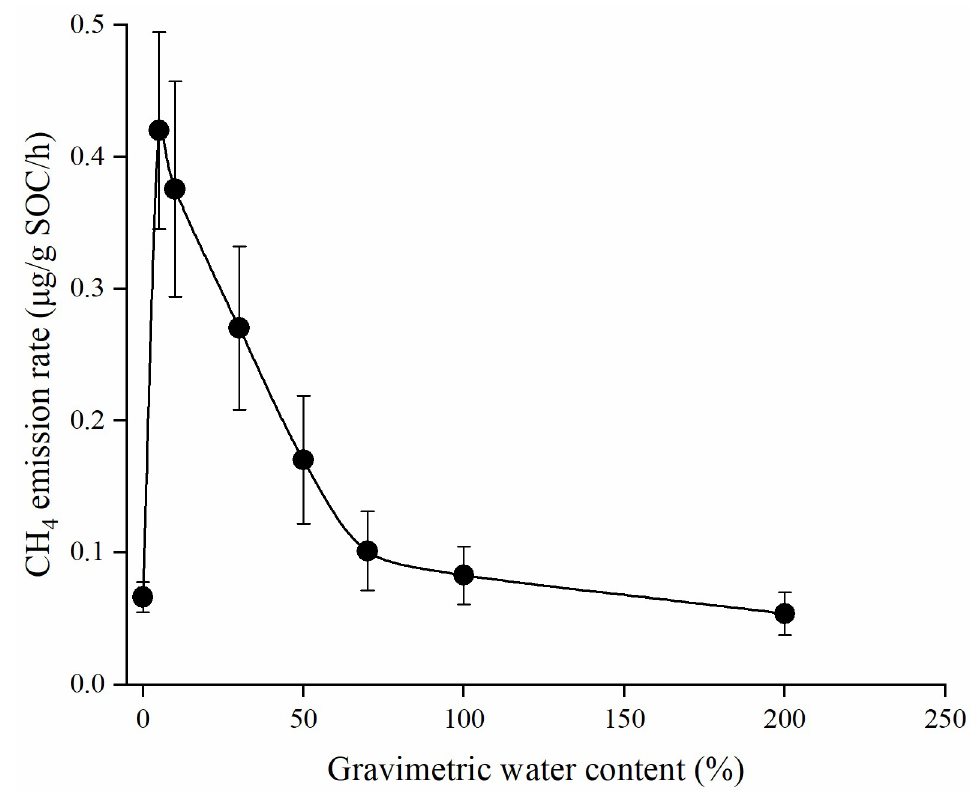
Fig 5. The emission rates of NM-CH 4 at different soil water contents (0%, 5%, 10%, 30%, 50%, 100%, 200%) treatments in aerobic environment at 70 ˚C.